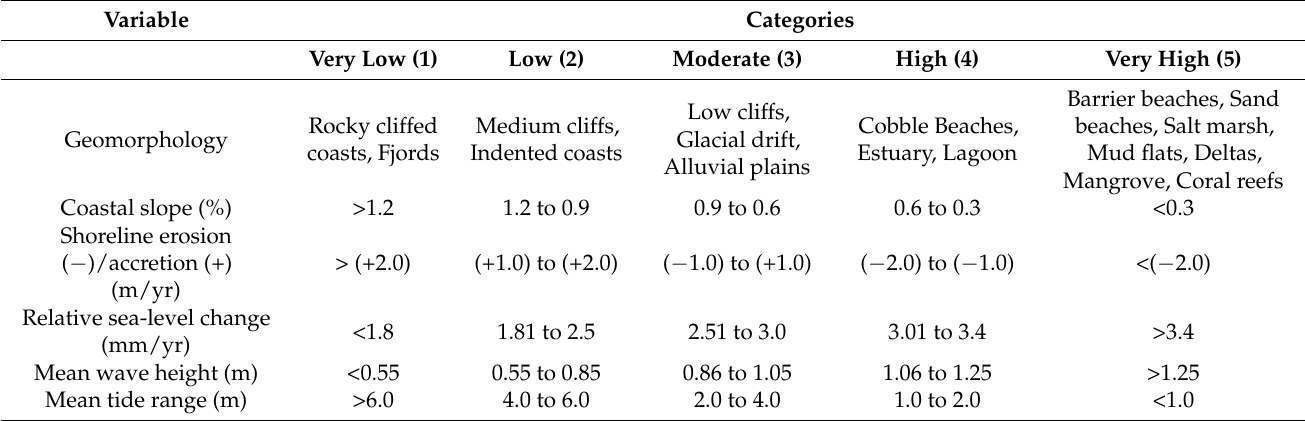
Table 1. Ranges for vulnerability ranking of the six variables used, shown together with their thresholds according to [17,18] approaches.